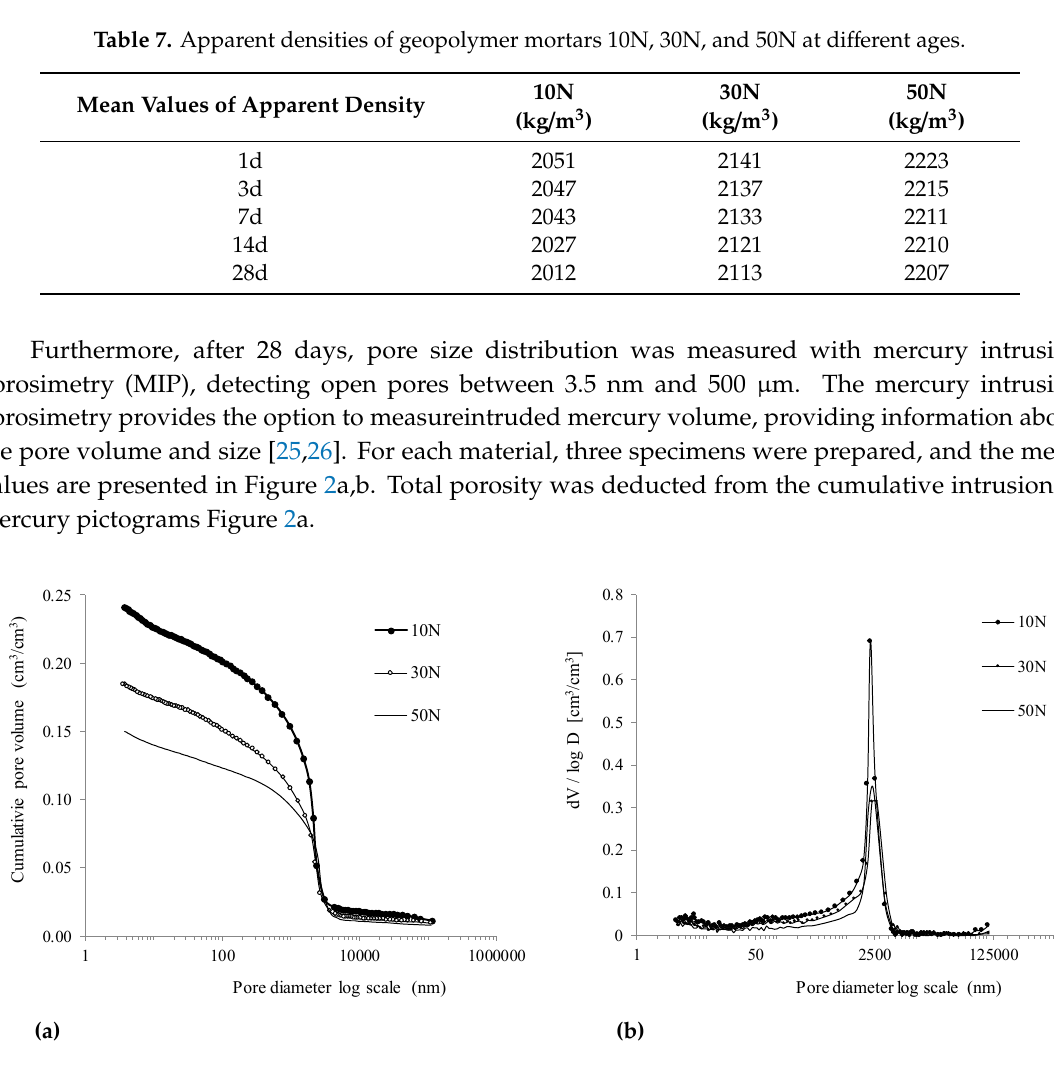
Figure 2. ( a ): Total porosity of geopolymer mortars 10N, 30N and 50N ( b ): Pore size distribution of Figure 2. (a): Total porosity of geopolymer mortars 10N, 30N and 50N (b): Pore size distribution of geopolymer geopolymer mortars.